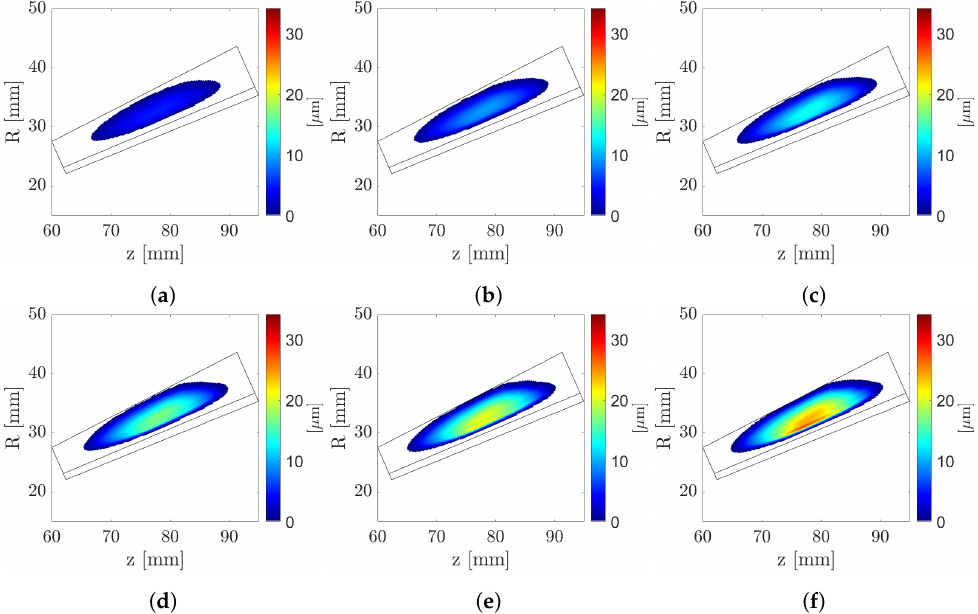
Figure 13. Evolution of the pinion (cumulative) wear pattern with a geometry update every 5